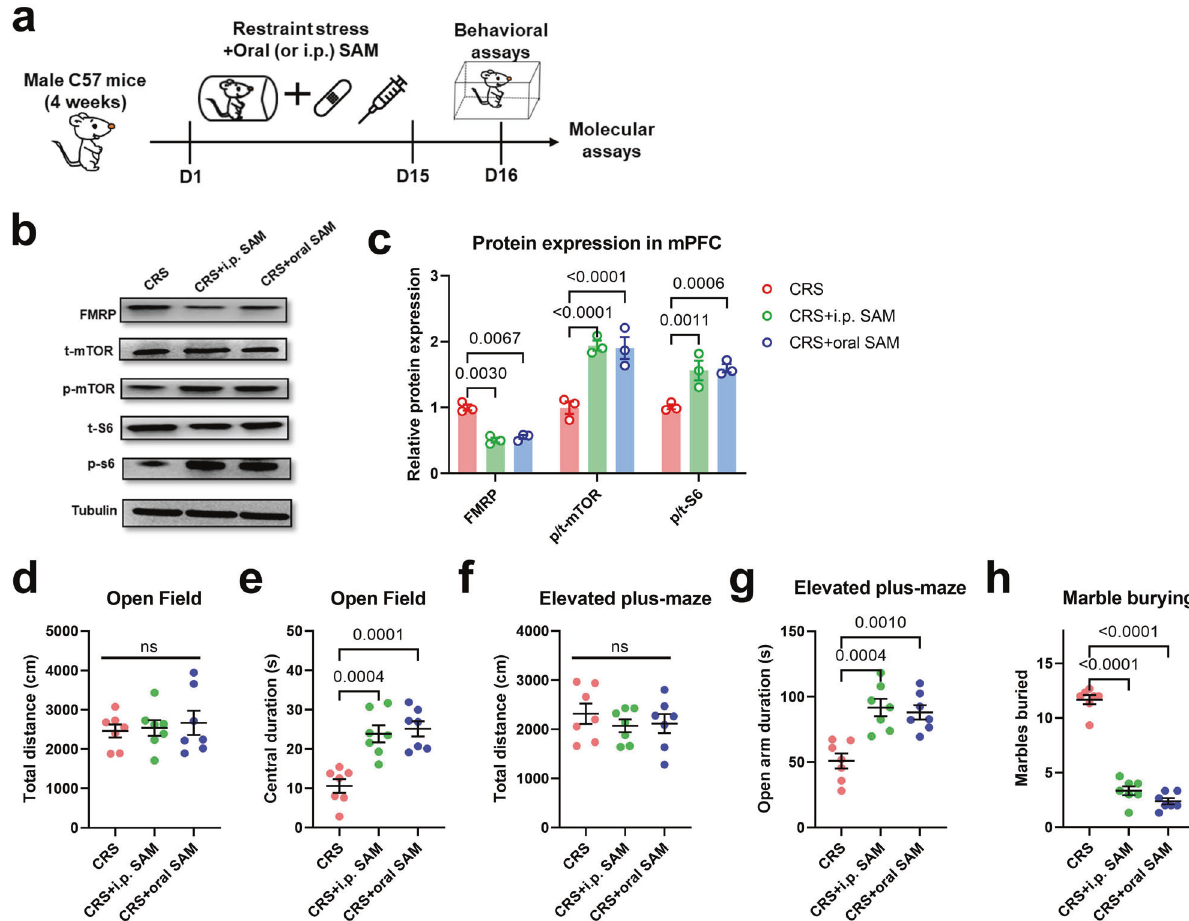
Fig. 8 Enhancement of brain RNA methylation activates mTOR pathway to improve stress resilience. a Experimental design for methyl donor supplement assay. b Representative blotting bands for FMRP, p-mTOR and p-S6. c Quanti fi cation analysis found that supplements of methyl donor molecules in CRS mice suppressed FMRP expression and activated the mTOR pathway. Multiple t-tests were used for comparisons between the two groups. N = 3 mice per group. d Total distance traveled in the open fi eld was unaffected. One-way ANOVA, F (2,18) = 0.2076, P = 0.8144. e Time spent in the central region in the open fi eld was increased under oral or i.p. SAM. One-way ANOVA, F (2,18) = 17.07, P < 0.0001. f The general locomotor activity on the elevated plus maze was unchanged. One-way ANOVA, F (2,18) = 0.5301, P = 0.5975. g Time duration in the open arm on the elevated plus maze was increased in CRS + i.p. or oral SAM group. One-way ANOVA, F (2,18) = 14.14, P = 0.0002. h The number of marbles buried was decreased by enhancing RNA methylation. One-way ANOVA, F (2,18) = 186.3, P < 0.0001. N = 7 mice in each group in ( d – h ). Tukey ’ s post-hoc test was used for comparisons between the two groups. All data were presented as mean ±